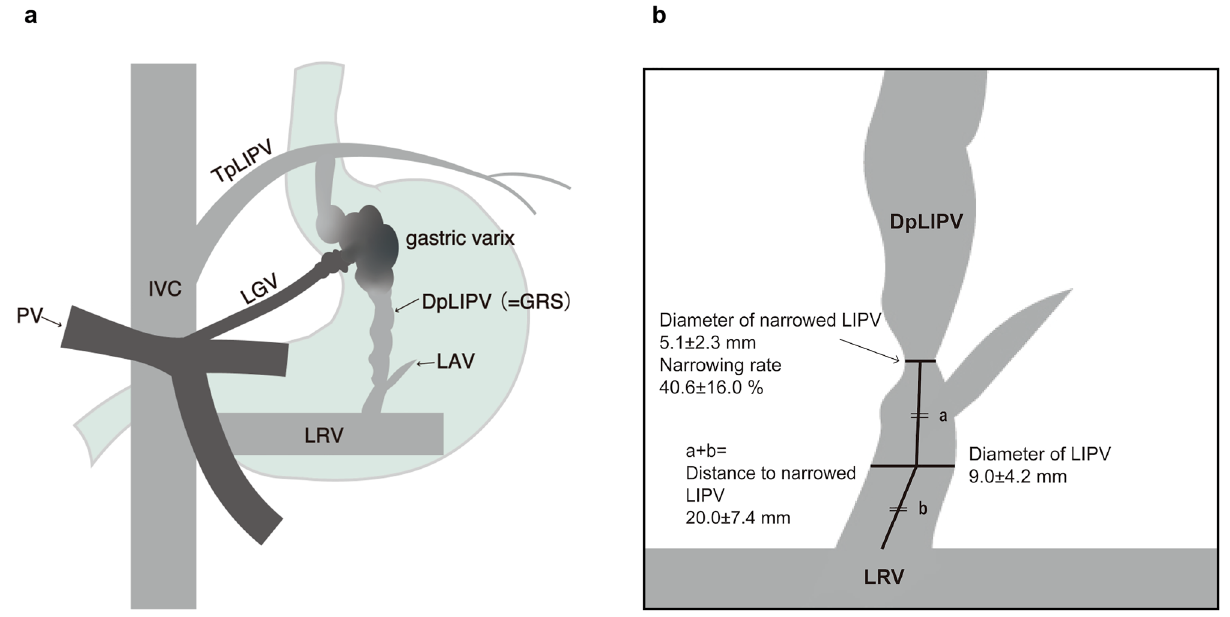
Figure 1. ( a ) Basic anatomy of LIPV and portosystemic venous circulation in a patient with portal hypertension. LIPV flows into two veins, namely, the transverse and descending portions of LIPV. The descending portion of LIPV merges with the left adrenal vein and flows into left renal vein, which is called the gastro-renal shunt. ( b ) The results of measurements on venograms of LIPV. IVC, Inferior vena cava; PV, Portal vein; LGV, Left gastric vein; TpLIPV, Transverse portion of the left inferior phrenic vein; DpLIPV, Descending portion of the left inferior phrenic vein; GRS, gastro-renal shunt; LAV, left adrenal vein; LRV, left renal